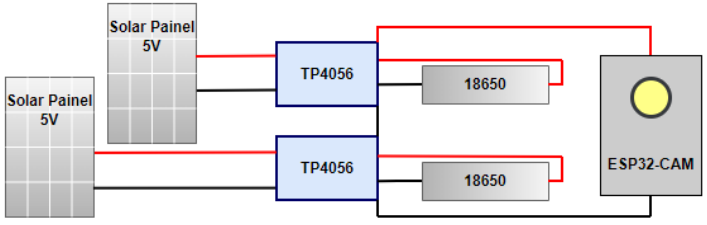
Figure 8. Diagram of ESP32-CAM powered by solar panels.